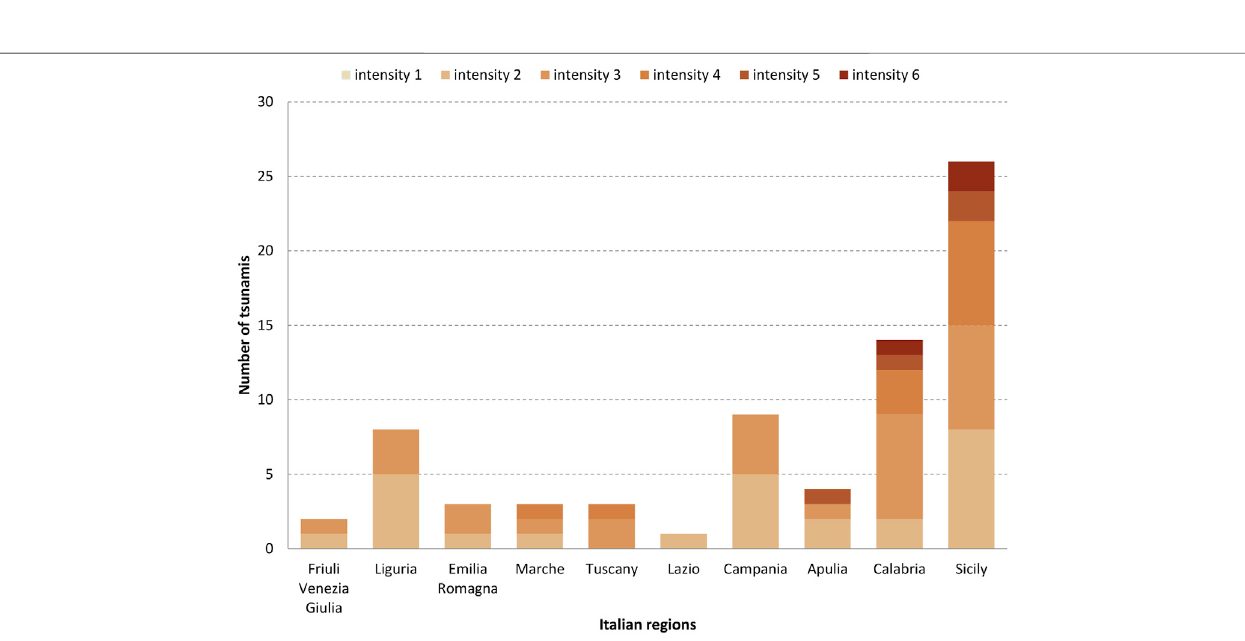
Frontiers in Earth Science |